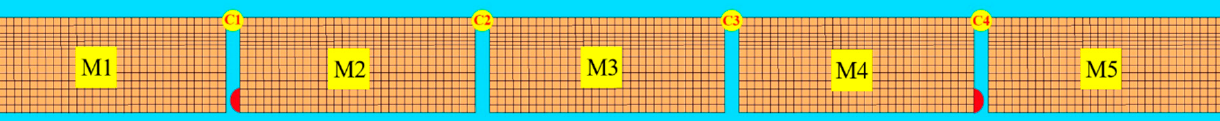
Figure 2. Hydrodynamic numerical model of the MIFS.